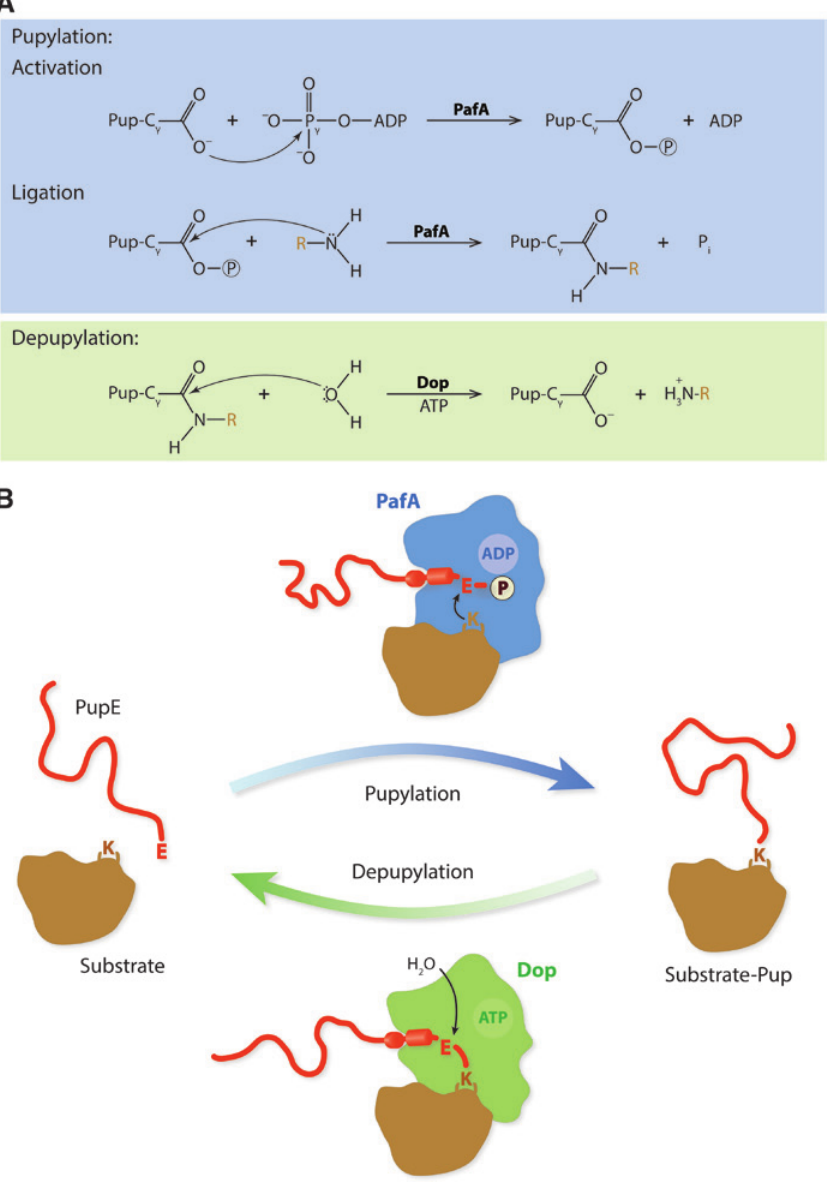
Figure 4: The pupylation-depupylation cycle. (A) The PafA-catalyzed pupylation reaction occurs in two steps. In the first step, the C-terminal γ -glutamyl carboxylate of Pup is activated by phosphoryl transfer from ATP, resulting in formation of a mixed anhydride. In the second step, the isopeptide bond between the substrate’s lysine and Pup is formed by a nucleophilic attack of the lysine ε -amino group on the γ -carbonyl carbon of the mixed anhydride of Pup. The isopeptide bond can be cleaved by Dop, a structural homolog of PafA. Dop catalyzes the nucleophilic attack of water on the carbonyl carbon of the isopeptide bond, thereby releasing Pup from the substrate. (B) Together, the two homologous enzymes PafA and Dop regulate the pupylation state of a protein via a pupylation-depupylation